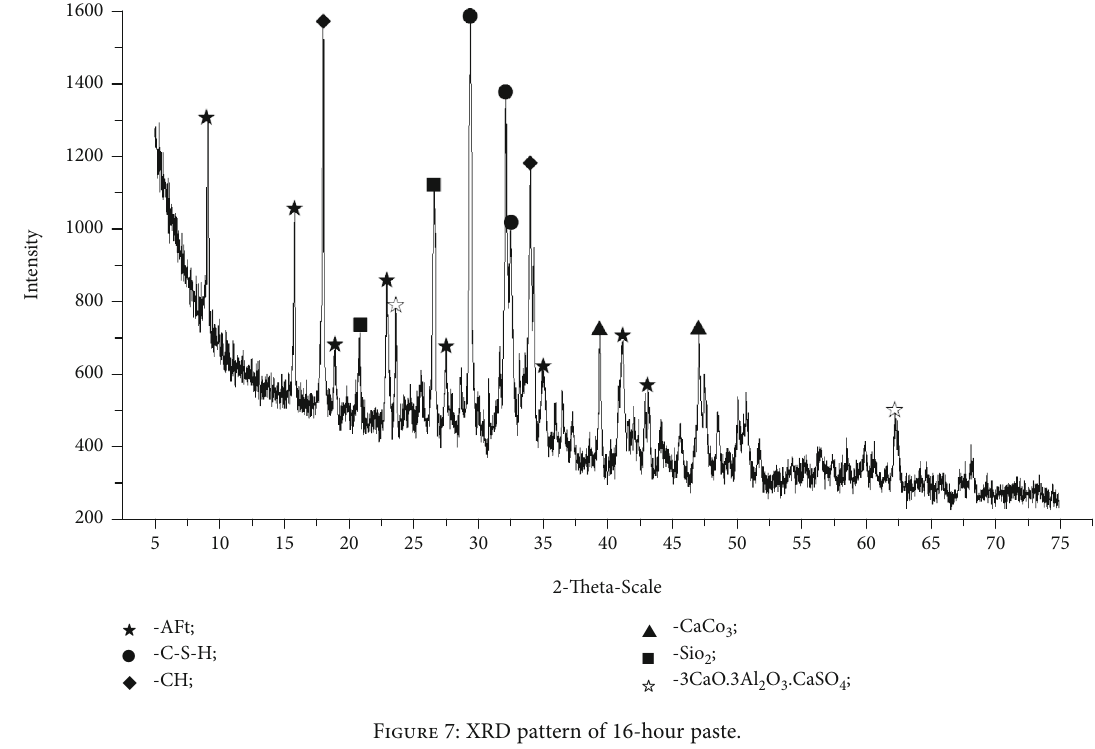
Figure 7: XRD pattern of 16-hour paste.